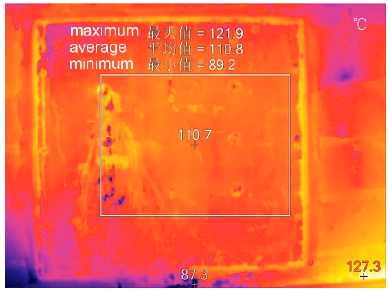
Figure 14. Test of the phase change heat storage device at 12 am.